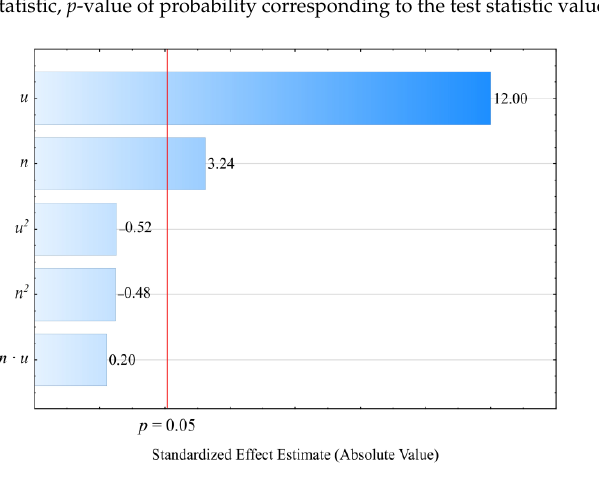
Figure 19. Pareto charts of the standardized effects for the empirical model density ρ ; the vertical line in the plot corresponds to the arbitrarily chosen level of significance ( p = 0.05).